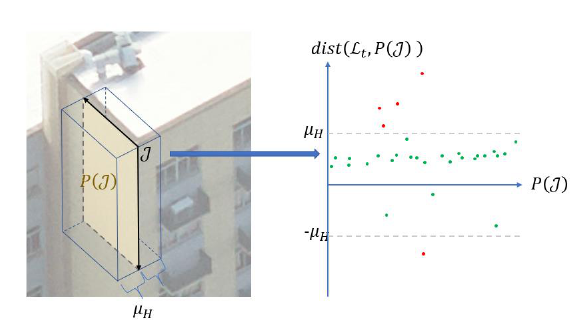
Figure 6. The points (green) within the buffer of the junction- plane will be constrained to the L-junction.